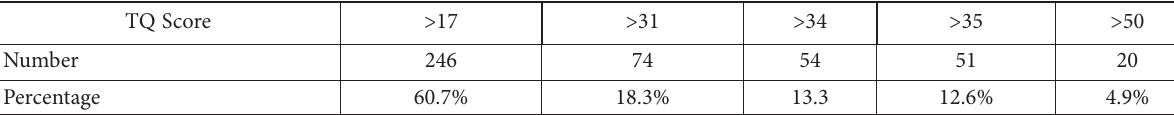
Table 3. Trypophobia Questionnaire (TQ) scores to the natural